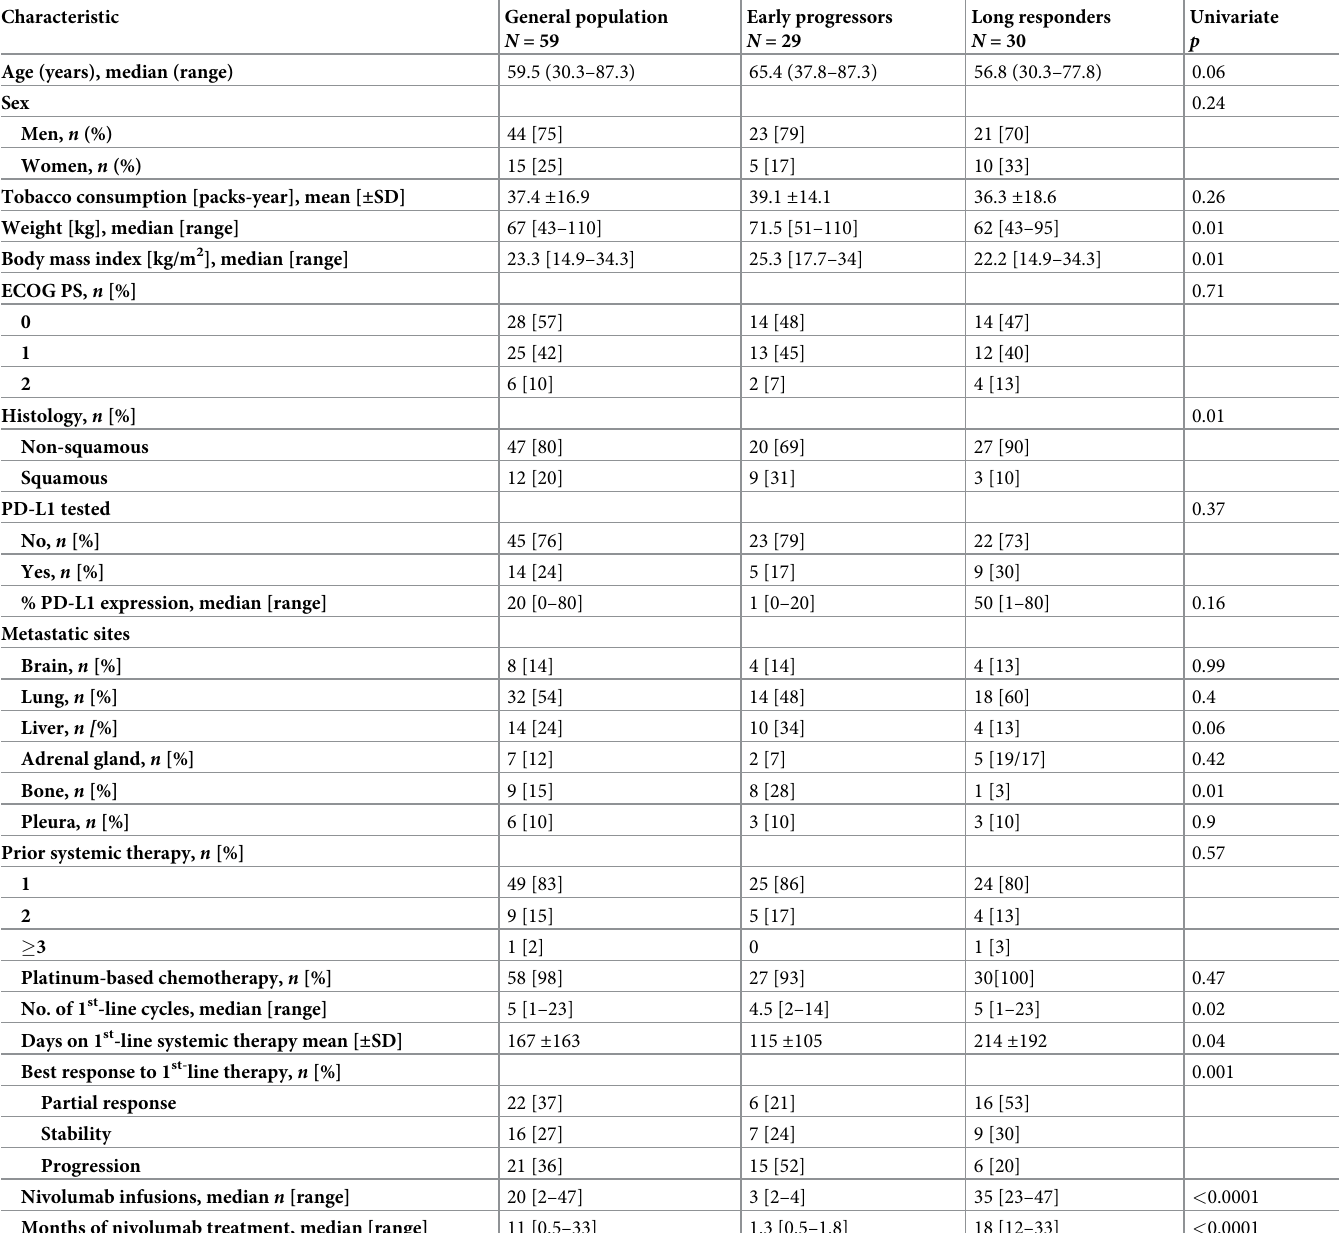
Table 1. Baseline clinical characteristics of NSCLC patients receiving nivolumab as second-or-more-line therapy.